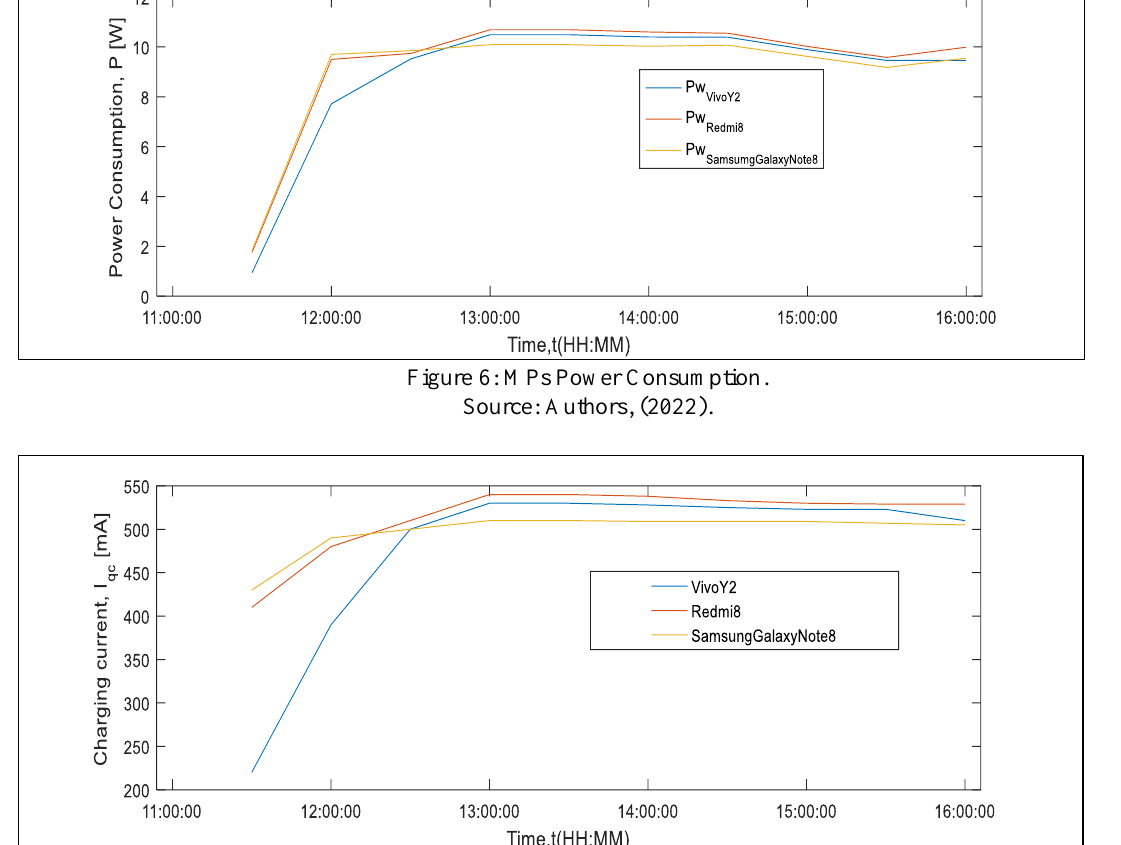
Figure 7: MPs Charging